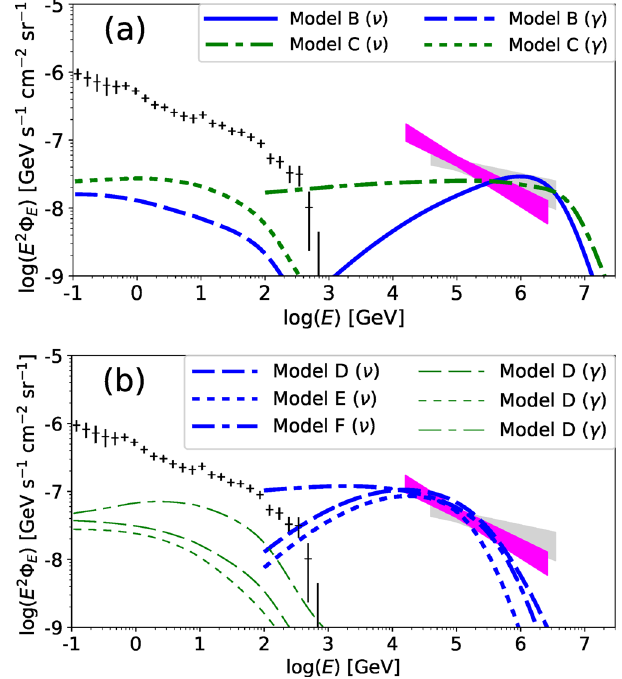
Fig. 6 All- fl avor neutrino and gamma-ray background intensities for power-law injection models and models for 10 – 100 TeV neutrinos. Data are provided by Fermi LAT 3 (black-plus; 1- σ errors with systematic and statistical uncertainties), and IceCube 4,118 (lightgrey and magenta regions; 68% con fi dence levels). a Power-law injection models that can account for the PeV neutrino data. The blue and green lines are for models B ( s inj = 1) and C ( s inj = 2) in Table 3, respectively. The solid and dotted-dashed lines indicate the neutrino spectra, and the dashed and dotted lines represent the gamma-ray spectra by proton-induced electromagnetic cascades. b Models for 10 – 100 TeV neutrinos. The thick-blue and thin-green lines are for neutrinos and proton-induced cascade gamma-rays, respectively. The dashed, dotted, dotted-dashed lines are for models D, E, F in Table 3,